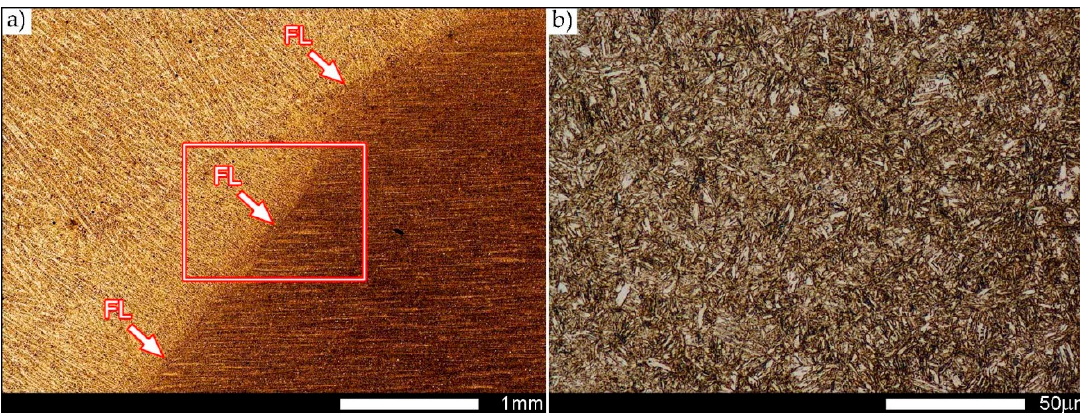
Figure 18. Microstructure of Hardox Extreme welded joint after heat treatment: ( a ) in the area marked FZ1 in Figure 6; ( b ) an enlarged image marked with frame in Figure 18a. Structure of fine-lath hardening martensite. The arrows (FL) indicate the very weakly outlined fusion line. Light microscopy, etched with 2% HNO 3 .